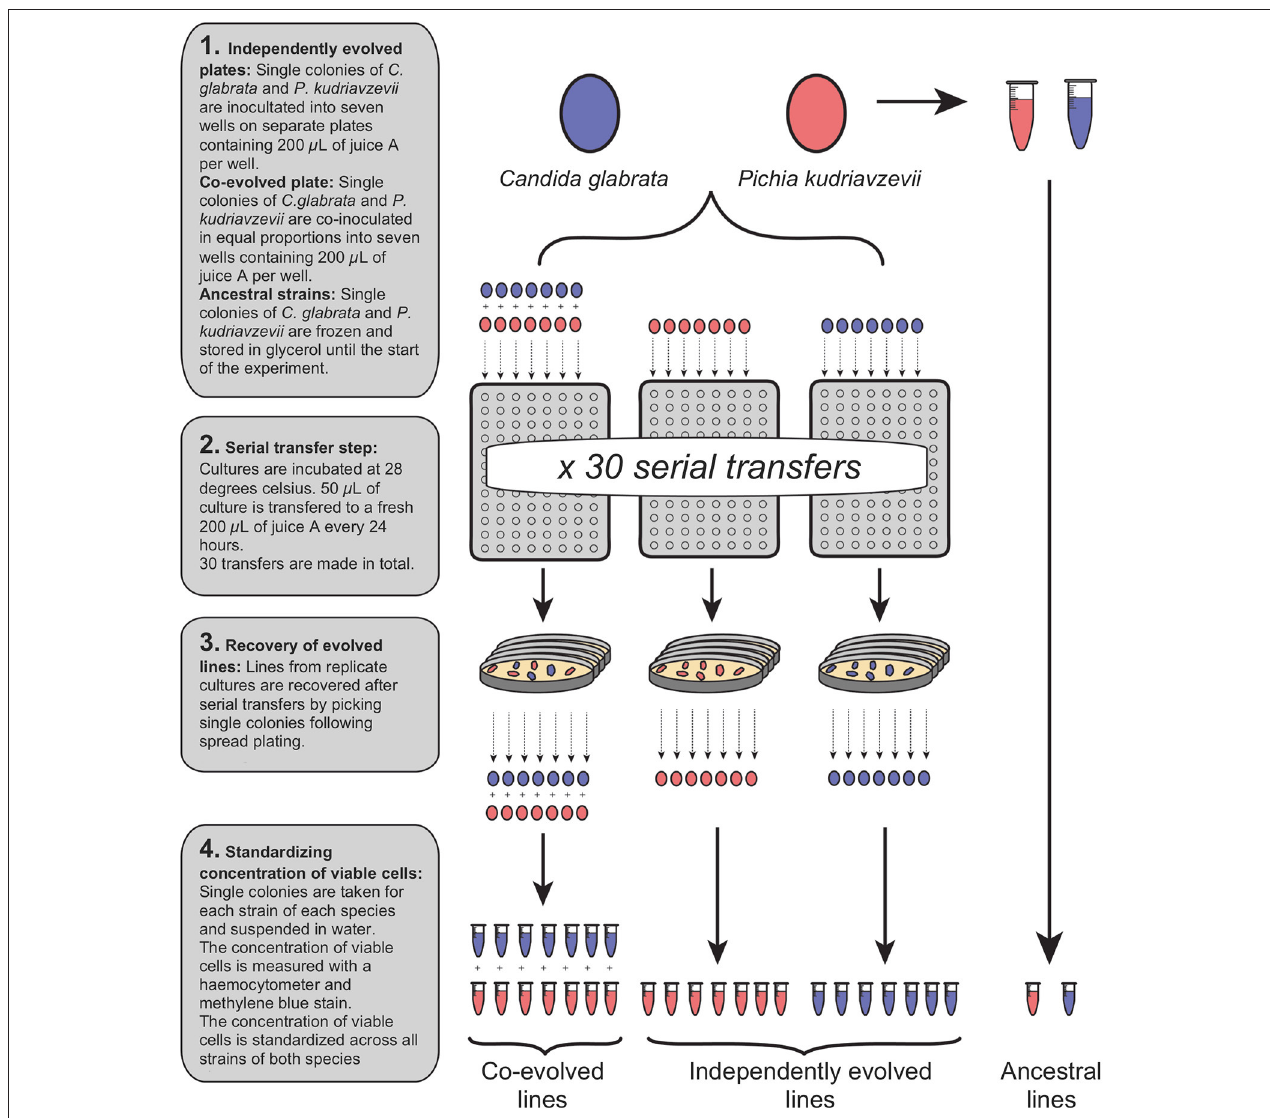
FIGURE 1 | Generation of independently evolved and co-evolved yeast lines from a single ancestral colony by serial transfer in fresh